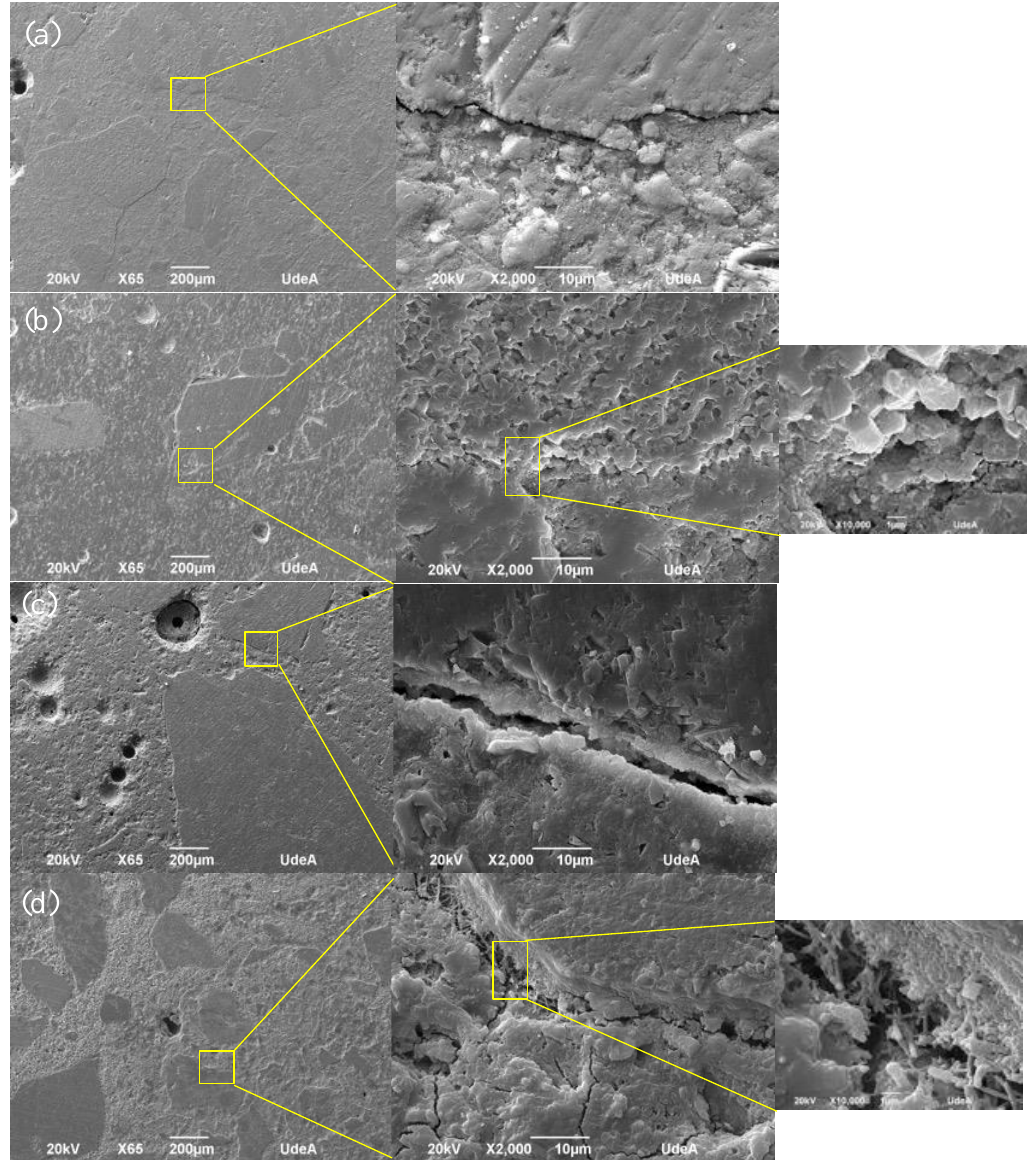
Figure 13. Microstructure of mortars made with RFA: ( a ) mortar made with 0% treated RFA, w/c: 0.45; ( b ) mortar made with 100% treated RFA (0.5 mol/L – 7d – 20 °C), w/c: 0.45; ( c ) mortar made with 0% treated RFA, w/c: 0.50; ( d ) mortar made with 100% treated RFA (0.5 mol/L – 7d – 20 °C), w/c: 0.50.